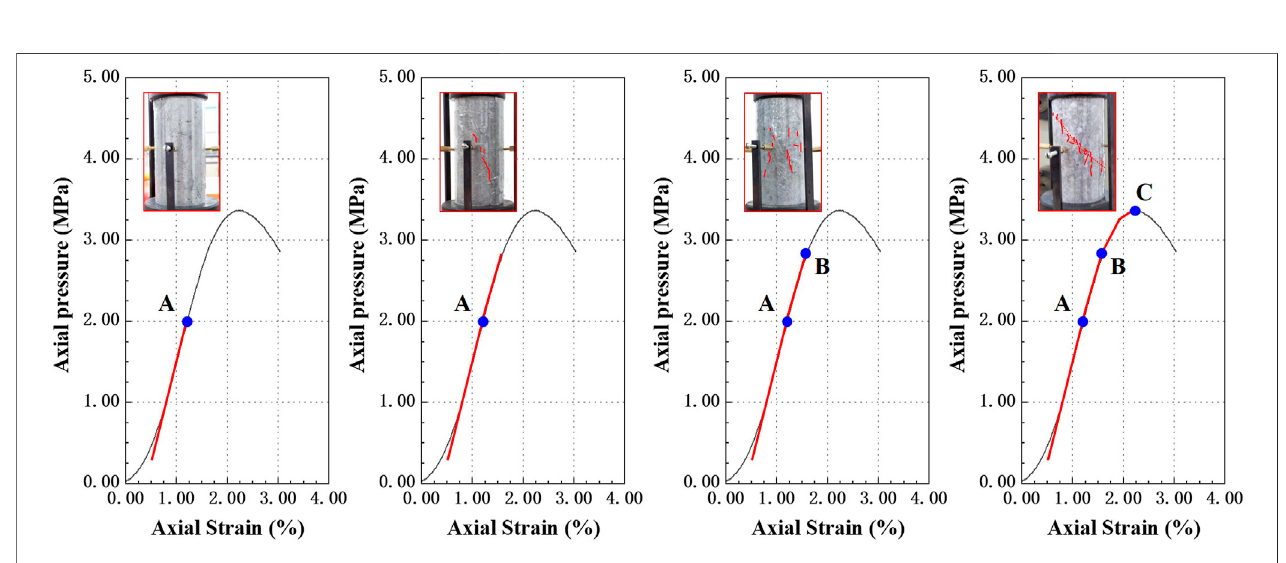
FIGURE 7 | Failure process of the cemented coal